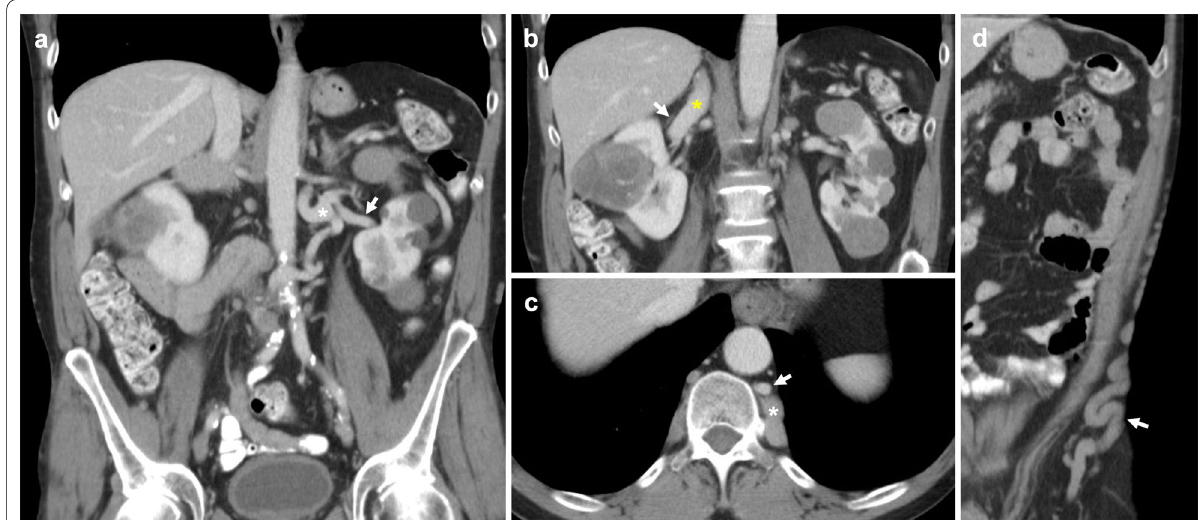
Fig. 10 Interrupted IVC (renal level) with azygos and hemiazygos continuation. Anomaly detected incidentally on imaging for a 55-year-old man with biopsy proven renal cell carcinoma. The paired common iliac veins continue as bilateral ascending lumbar veins draining into the azygos– hemiazygos system. a Contrast-enhanced coronal CT shows the left renal vein (arrow) draining into a tortuous paravertebral collateral (asterisk). b The right renal vein (arrow) joins the suprarenal IVC (asterisk). c Axial CT image depicts a left-sided paravertebral collateral (arrow) that drains into the hemiazygos vein (asterisk) sited posteriorly. d Coronal CT image with a prominent lateral abdominal wall collateral vein